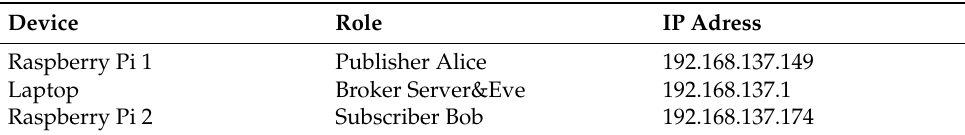
Table 2. IP address and role of each device.